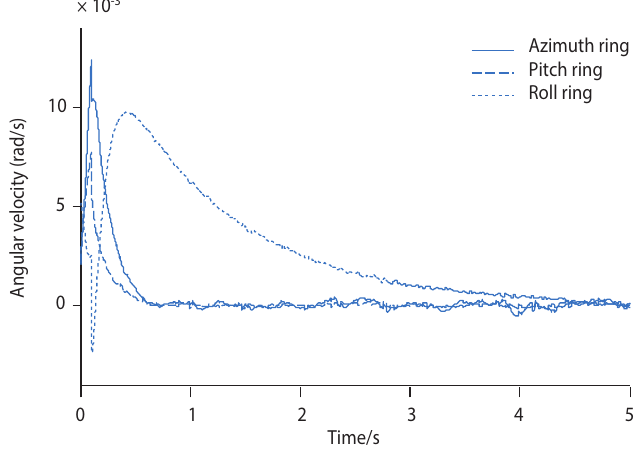
Figure 5. Simulation result of τ